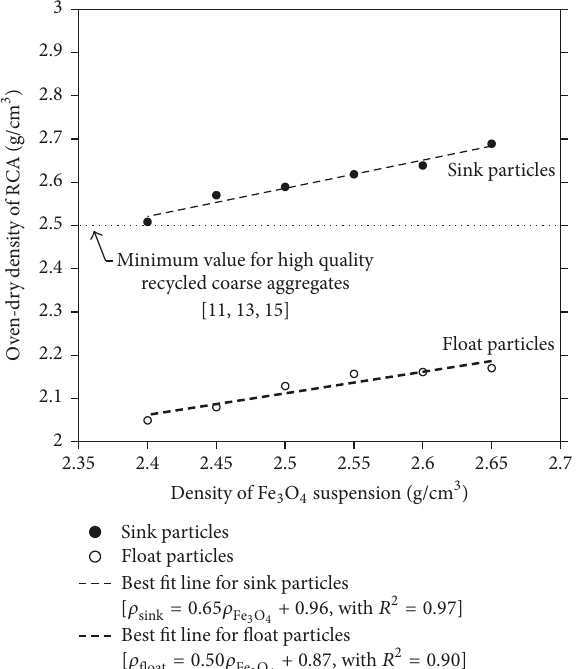
Figure 7: The variations of the oven-dry density of sink and float in the heavy medium separation process with a density of Fe 3 O 4 suspension in the drum separator.